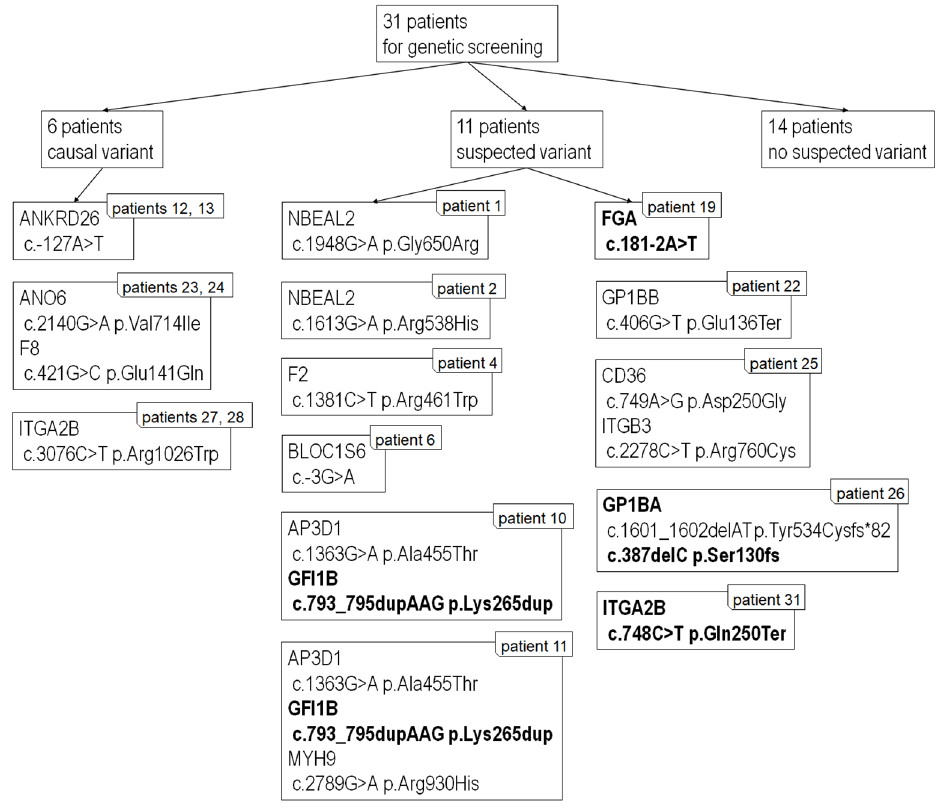
Figure 3. Summary of NGS results. Novel variants are in bold. All variants are heterozygous. For reference sequences and other information see Table 5.